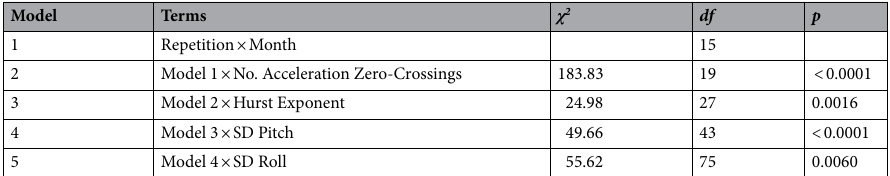
Table 3. Building of growth curve models in terms of highest-order interaction and chi-square ( χ 2 ) tests for improvements in model fit. In addition, participant was incorporated as a random effect for the intercept as well as its slope with respect to month into all the models.